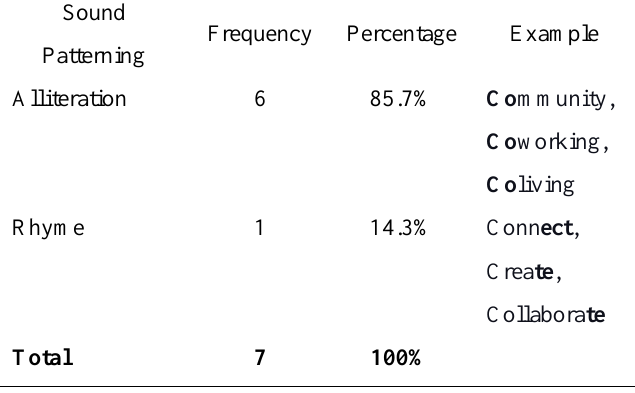
TABLE 1 | Sound Patterning in Coworking Spaces Headlines